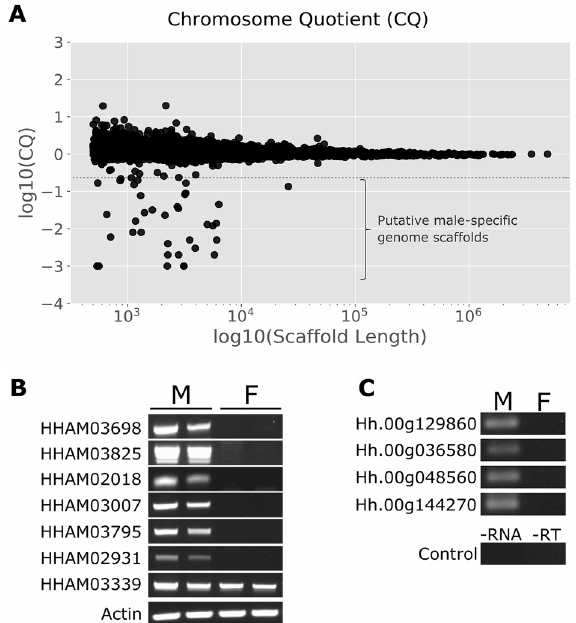
Figure 7. Identification of male-specific genome scaffolds. ( A ) The Chromosome Quotient (CQ) was plotted as Log10(CQ) across the genome scaffolds [Log10(Scaffold Length)]. Each black dot represents the Log10(CQ) of single scaffolds. Dots below − 0.7 (threshold indicated by a dotted line) were considered as male-specific. ( B ) PCR-DNA marker analysis for selected candidate male-specific scaffolds using genomic DNA from males (M) and females (F). Cropped images from several electrophoresis gels were combined for B. The full-length electrophoresis gel images are shown in Supplementary Fig. S5. ( C ) RT-PCR for candidate Y-linked genes using total RNA from males (M) and females (F). Control RT-PCR assays for gDNA contamination were performed using primers for Hh00g129860, with no male-RNA template (-RNA) or lacking retro-transcriptase enzyme (-RT). Cropped images from the same electrophoresis gel were combined for C. The full-length electrophoresis gel image is shown in Supplementary Fig.